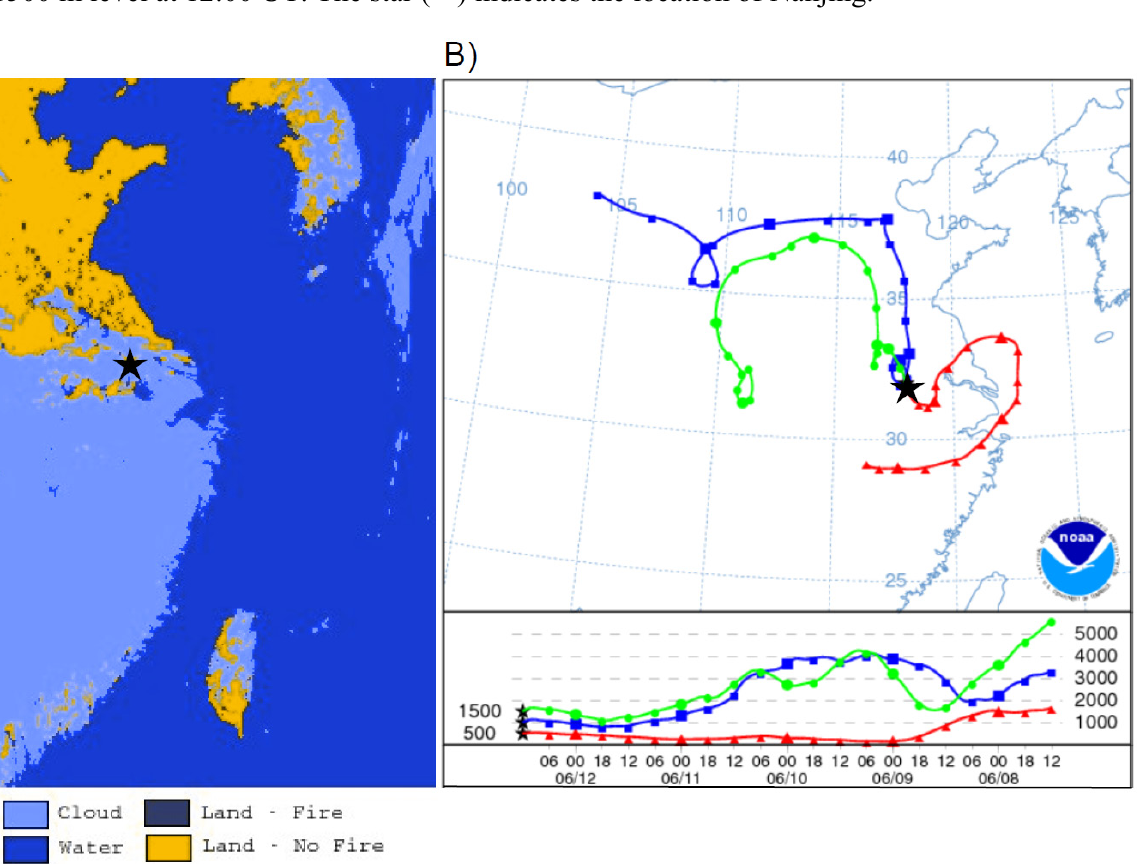
Figure 12. On 12 June 2011 ( A ) Fires from MODIS (defined in text) five-min Fire product V2 and ( B ) a five-day backward trajectory from Nanjing starting at the 500, 1000, and 1500 m level at 12:00 UT. The star (  ) indicates the location of